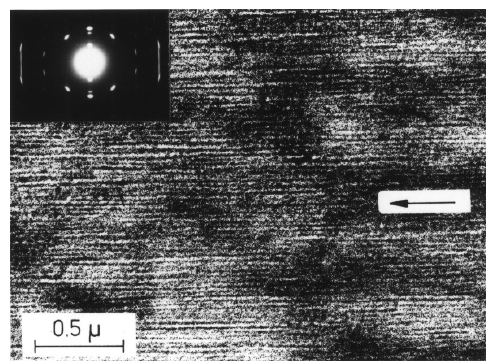
Figure 12. X-ray powder diffraction profiles of samples of iPBu of same stereoregularity but different molecular weight crystallized from the melt by cooling the melt to room temperature (or lower temperature) at the indicated cooling rates. The (110) I , (300) I and (220) I /(211) I reflections of form I at 2θ = 9.9°, 17.3° and 20.5°, and the (200) II , (220) II and (213) II /(311) II reflections of form II at 2θ = 11.9°, 16.9° and 18.3° are indicated. Reproduced with permission from Ref. [80], copyright 2009 American Chemical Society.